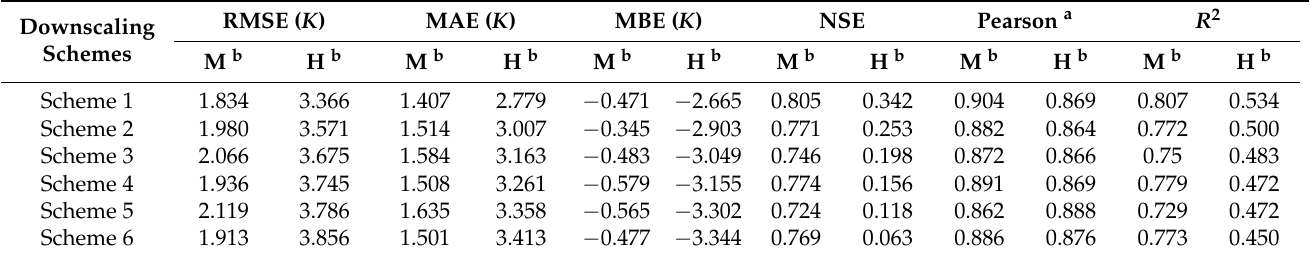
lated with the reference LST. The RMSE values for HUTS and MFGWML are 3.366 and 1.834 K, respectively. The MAE values for HUTS and MFGWML are 2.779 K and 1.407 K, respectively. These values demonstrate that MFGWML improves the results with a 45.514% decrease and a 49.370% decrease in the RMSE value and MAE value, respectively. The MBE values for HUTS and MFGWML are − 2.665 and − 0.471K, respectively, indicating that MFGWML is more reliable than HUTS. The NSE values for HUTS and MFGWML are 0.342 and 0.805, respectively. The R 2 values for HUTS and MFGWML are 0.534 and 0.807, respectively. These statistical results show that MFGWML outperforms HUTS. The other five downscaling schemes have similar results, which indicates that the MFGWML model is robust at different scales. Table 13. Accuracy evaluation indicators of MFGWML and HUTS for the six downscaling schemes implemented around the central urban